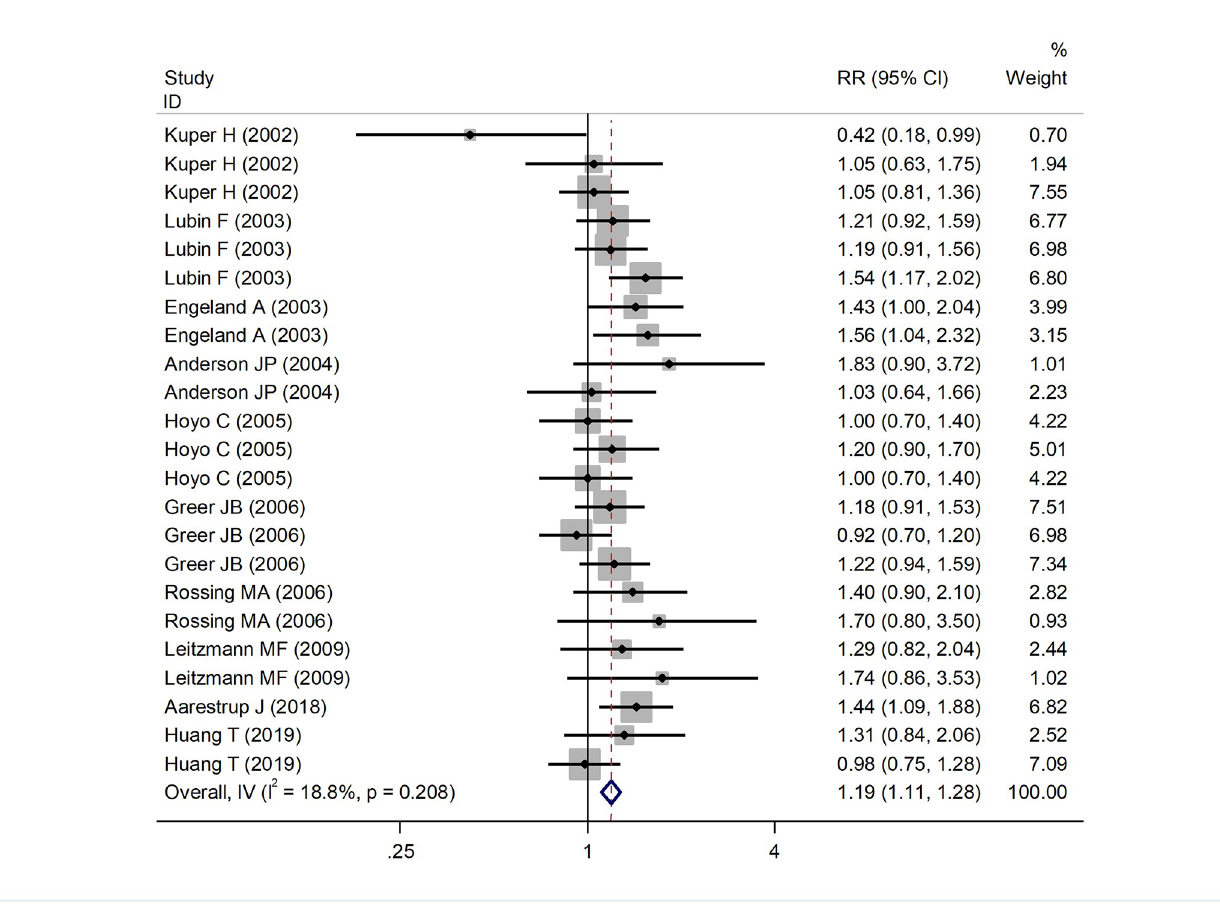
Fig 2. Association of obesity in children and adolescents with ovarian cancer in studies providing relative risks (RRs) and 95% confidence intervals